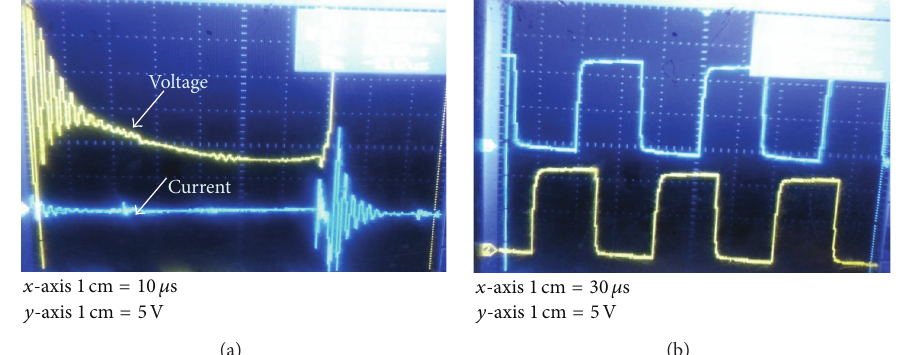
Figure 21: Experimental results of TSSSBC. (a) Voltage across the switch. (b) Pulses for TSSSBC (120 ∘